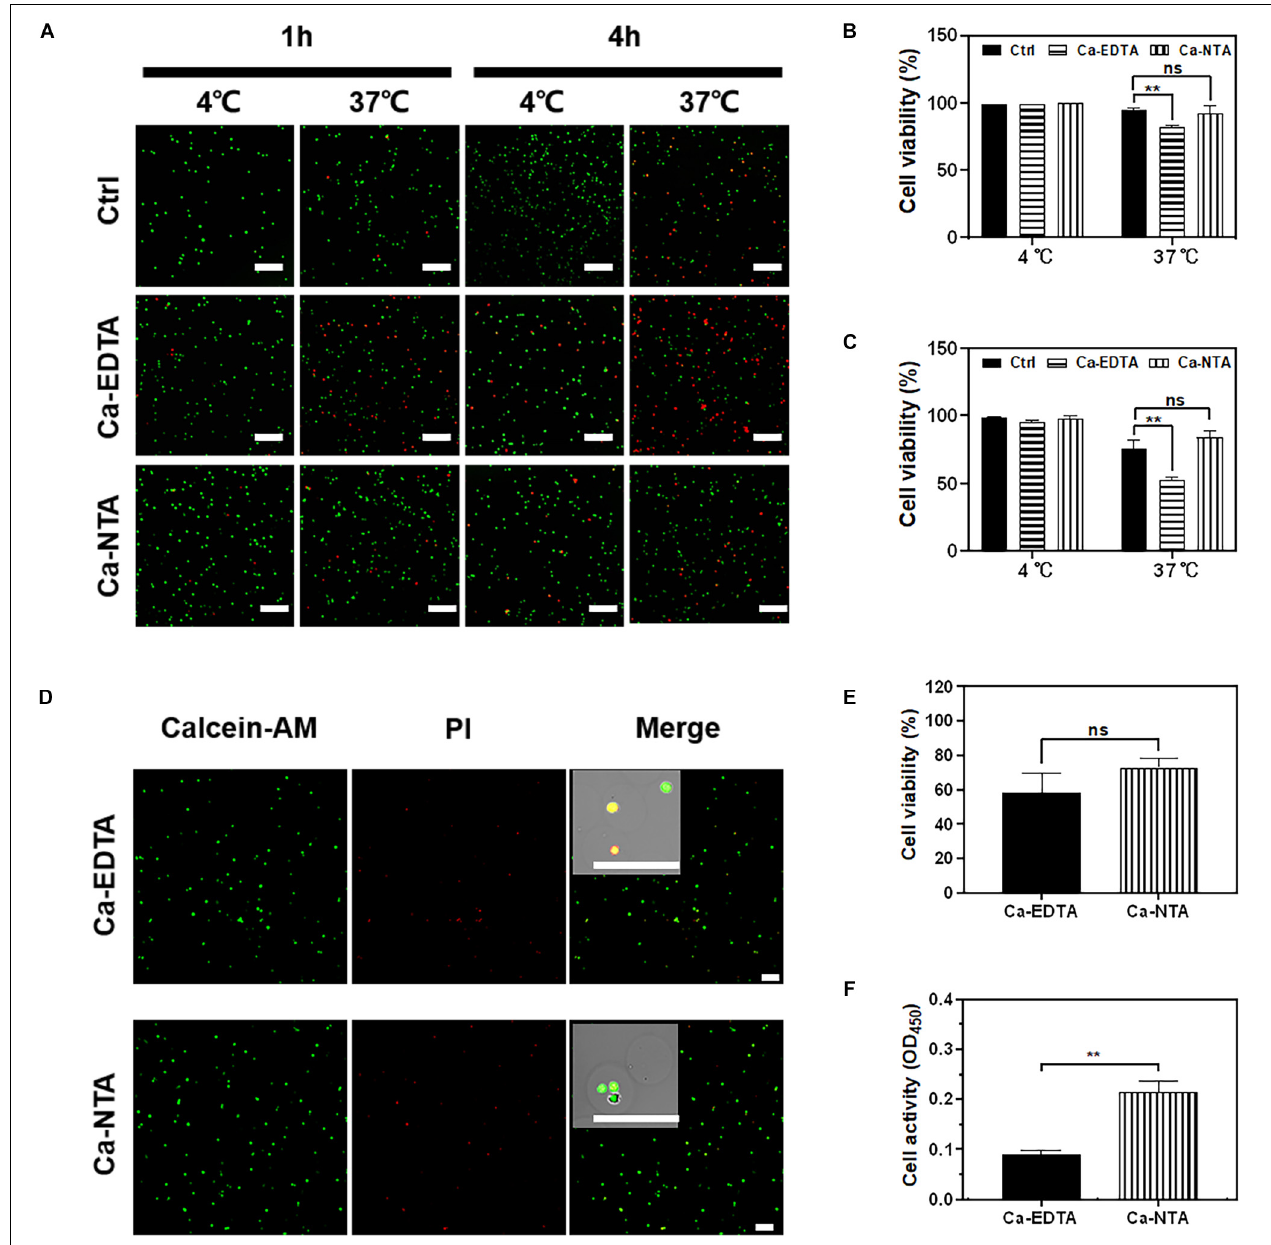
FIGURE 4 | Evaluation of cell viability for microfluidic fabrication process. NIH3T3 fibroblasts were cultured in medium containing 1 wt% Na-alginate and 50 mM Ca-EDTA or Ca-NTA, incubated in a sealed syringe at 4 ◦ C and 37 ◦ C for 1 and 4 h, respectively. (A) The confocal microscopic images of live (green) and dead (red) cells stained by Calcein-AM and ethidium homodimer, respectively. The cells were incubated (B) 1 h and (C) 4 h. The numbers of live and dead cells were counted with the aid of ImageJ. The viability of NIH3T3 fibroblasts in microgels. To encapsulate cells, Ca-NTA and Ca-EDTA were used as the crosslinker. (D) Live (green) and dead (red) cells were stained by calcein-AM and ethidium homodimer, respectively. (E) The numbers of live and dead cells from microgels that were triggered by Ca-NTA or Ca-EDTA were counted with the aid of ImageJ. (F) Cell activity of encapsulated cells was assessed by CCK-8 assay after 24 h of culture. Scale bar is 200 µ m ( ∗∗ p < 0 .